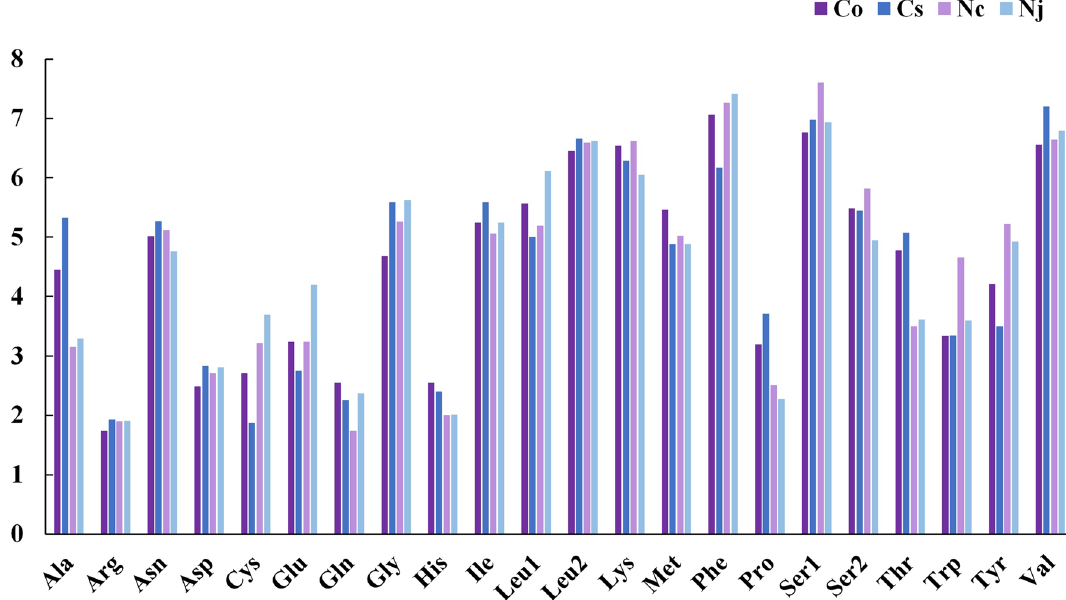
Figure 2. Percentage of each amino acid for proteins coded by PCGs in the four newly obtained mitochondrial genomes of C. oualaniense , C. sowerbianum , N. chamaeleon , and N. japonica